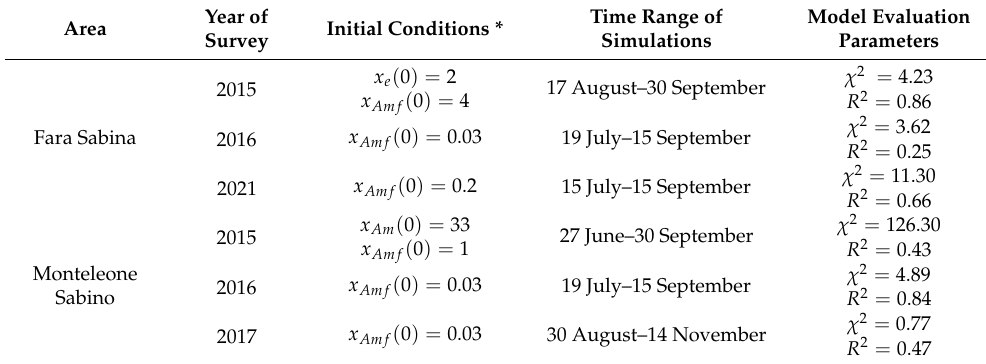
Table 4. Resume of model validation in the three years and both experimental orchards.